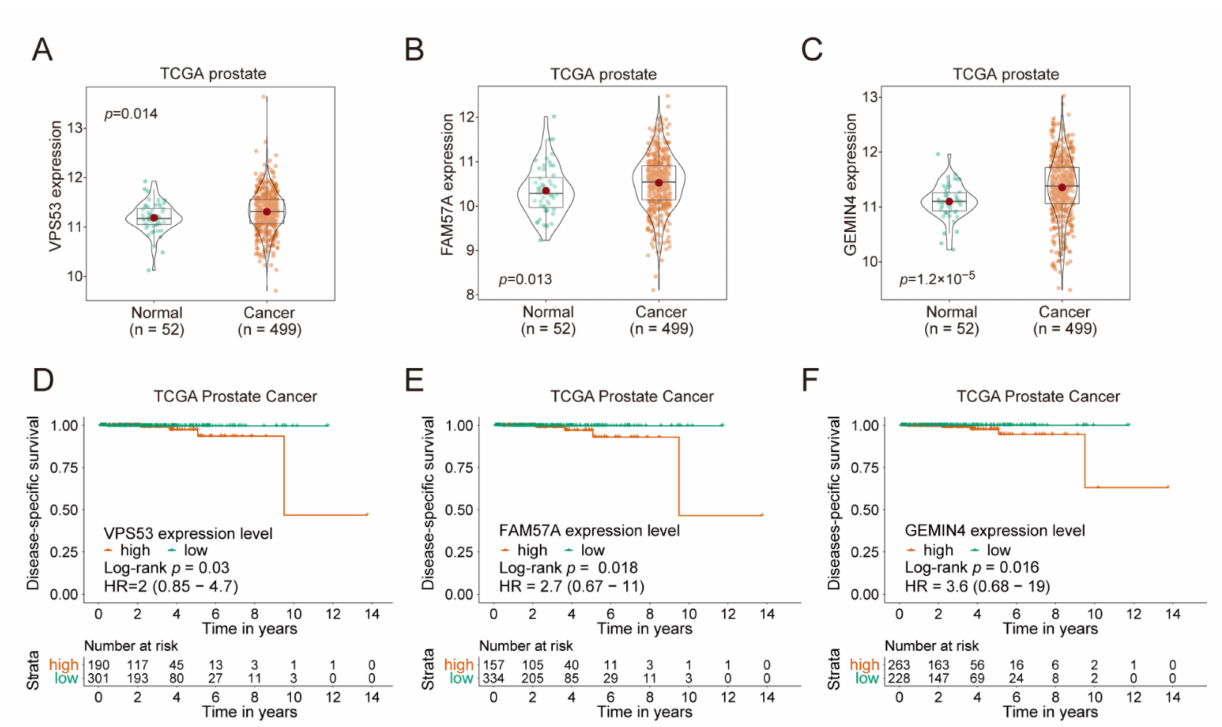
Figure 7. VPS53 , FAM57A , and GEMIN4 affect cancer progression. ( A – C ) Violin box plot to compare gene expression of VPS53 ( A ), FAM57A ( B ), and GEMIN4 ( C ) at mRNA level between normal and cancer tissues from TCGA. Gene expression value was showed as log2 value of reads data, with the mean, median, 0.25, and 0.75 quantiles represented. p values were examined by Mann-Whitney U tests. ( D – F ) Kaplan–Meier disease-specific survival analysis of prostate cancer patients that were stratified into two groups according to the expression level of VPS53 (strata point = 2.52) ( D ), FAM57A (strata point = 3.92) ( E ), and GEMIN4 (strata point = 3.06) ( F ). p values were calculated by the log-rank test, with a 95% confidence